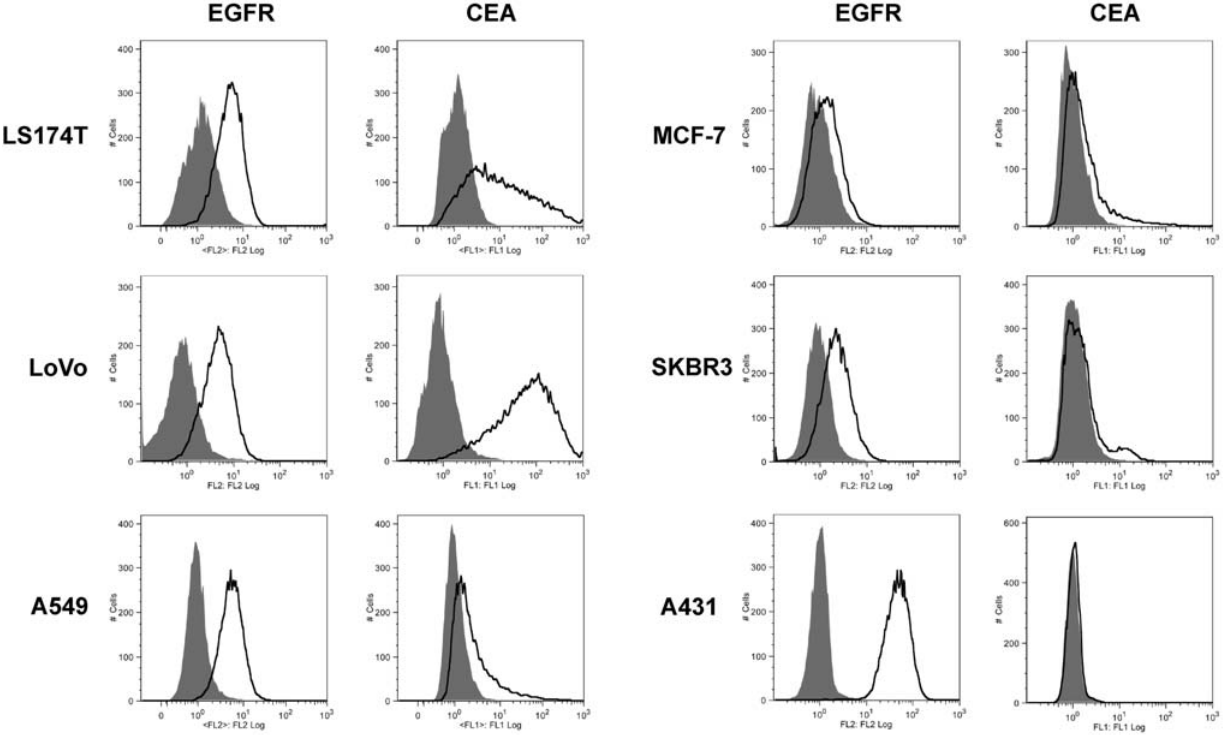
Figure 1. Flow cytometry analysis of the expression of EGFR and CEA on various tumor cell lines (grey filled, cells alone; black line, cells incubated with either anti-EGFR or anti-CEA monoclonal